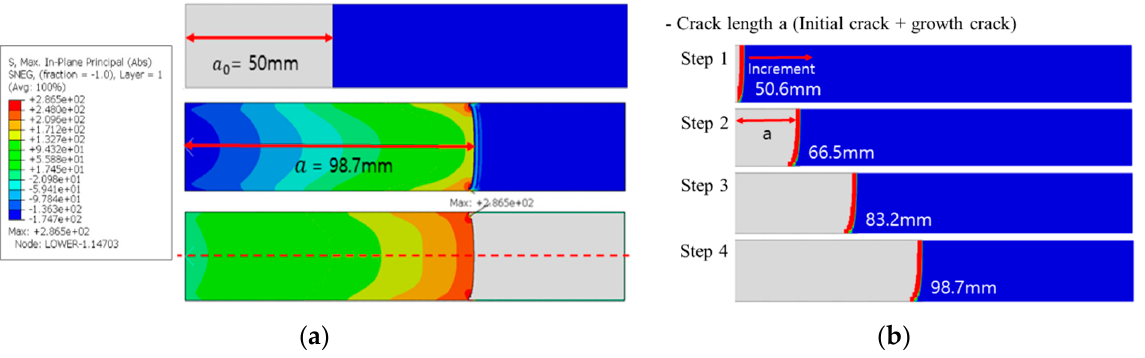
Figure 13. FE analysis result shape of Mode I: ( a ) in-plane stress contour and ( b ) crack growth length at applied displacement.